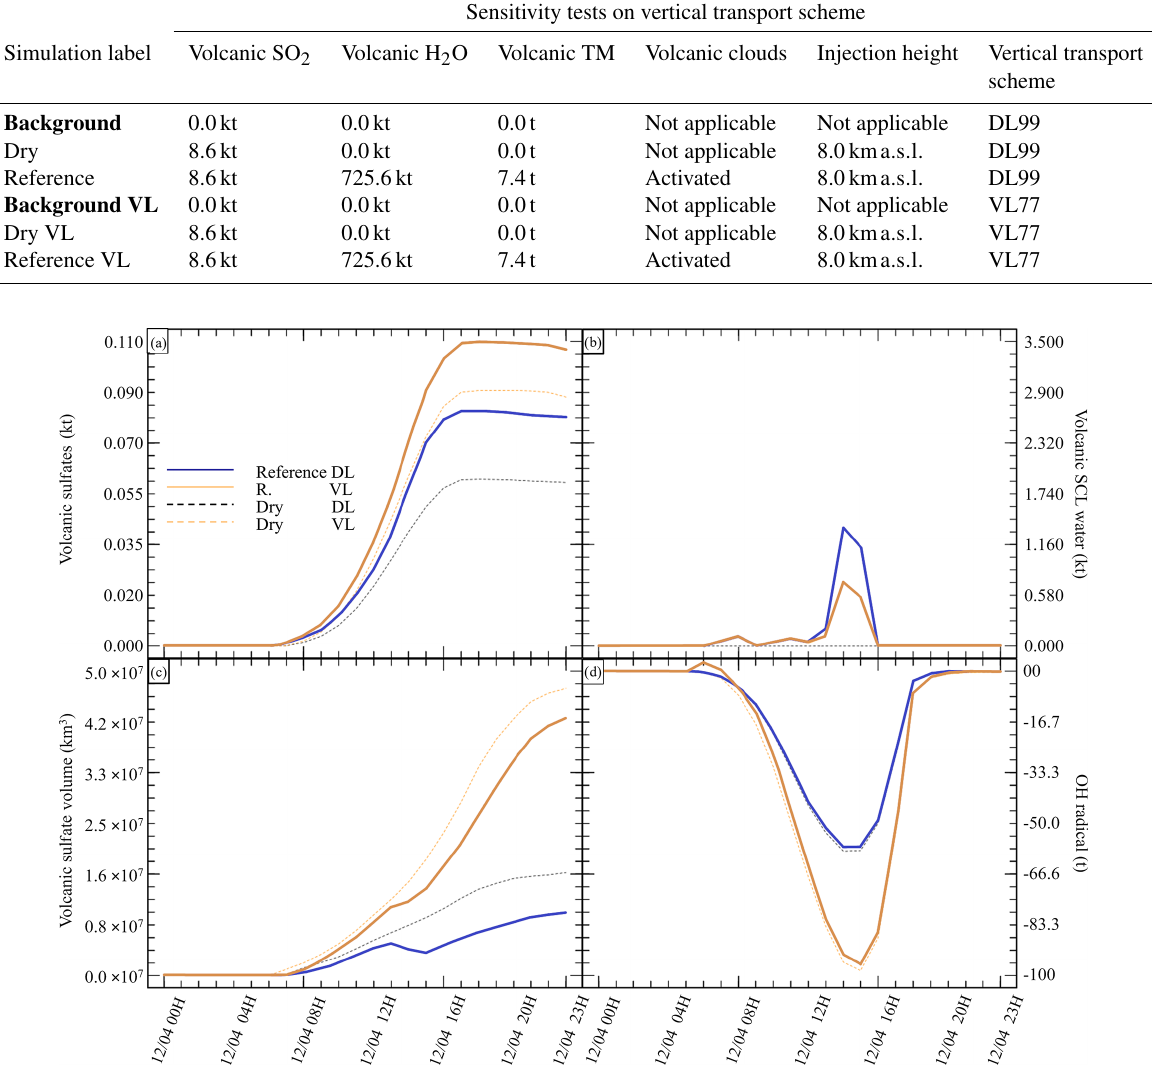
Figure 6. Sensitivity tests on injection height for (a) sulfate aerosols (SO 2 (km 3 ) ⊂ 25% of SO 2 − mass and (d) the OH radical (t). The Reference simulation is the closest to a realistic case. All time series represent 4(p) differences relative to the Background simulation (the simulation without volcanic